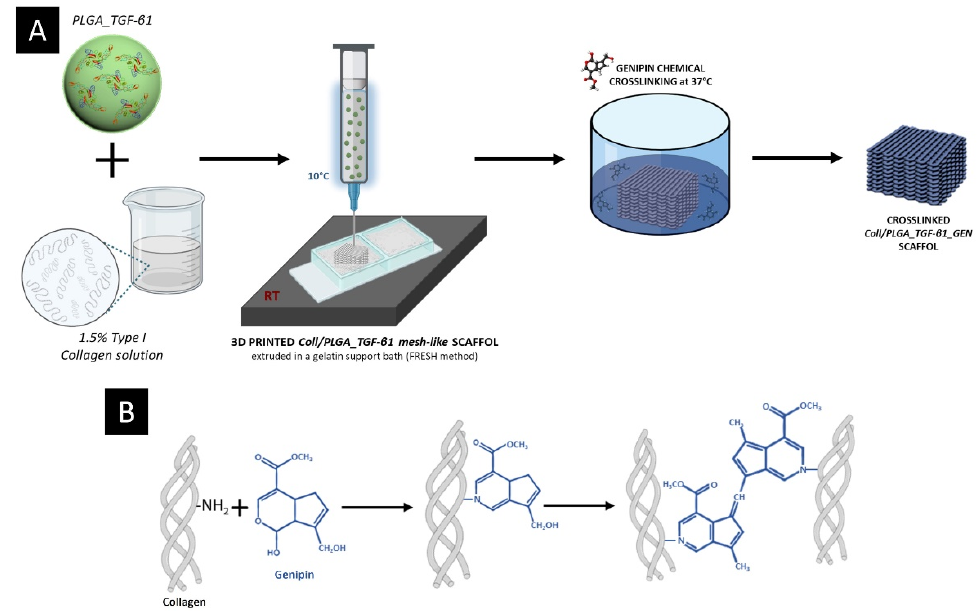
Figure 2. ( A ) Schematic representation of Coll/PLGA_TGF- β 1_GEN scaffold realization process and ( B ) mechanism of genipin chemical crosslinking of collagen.